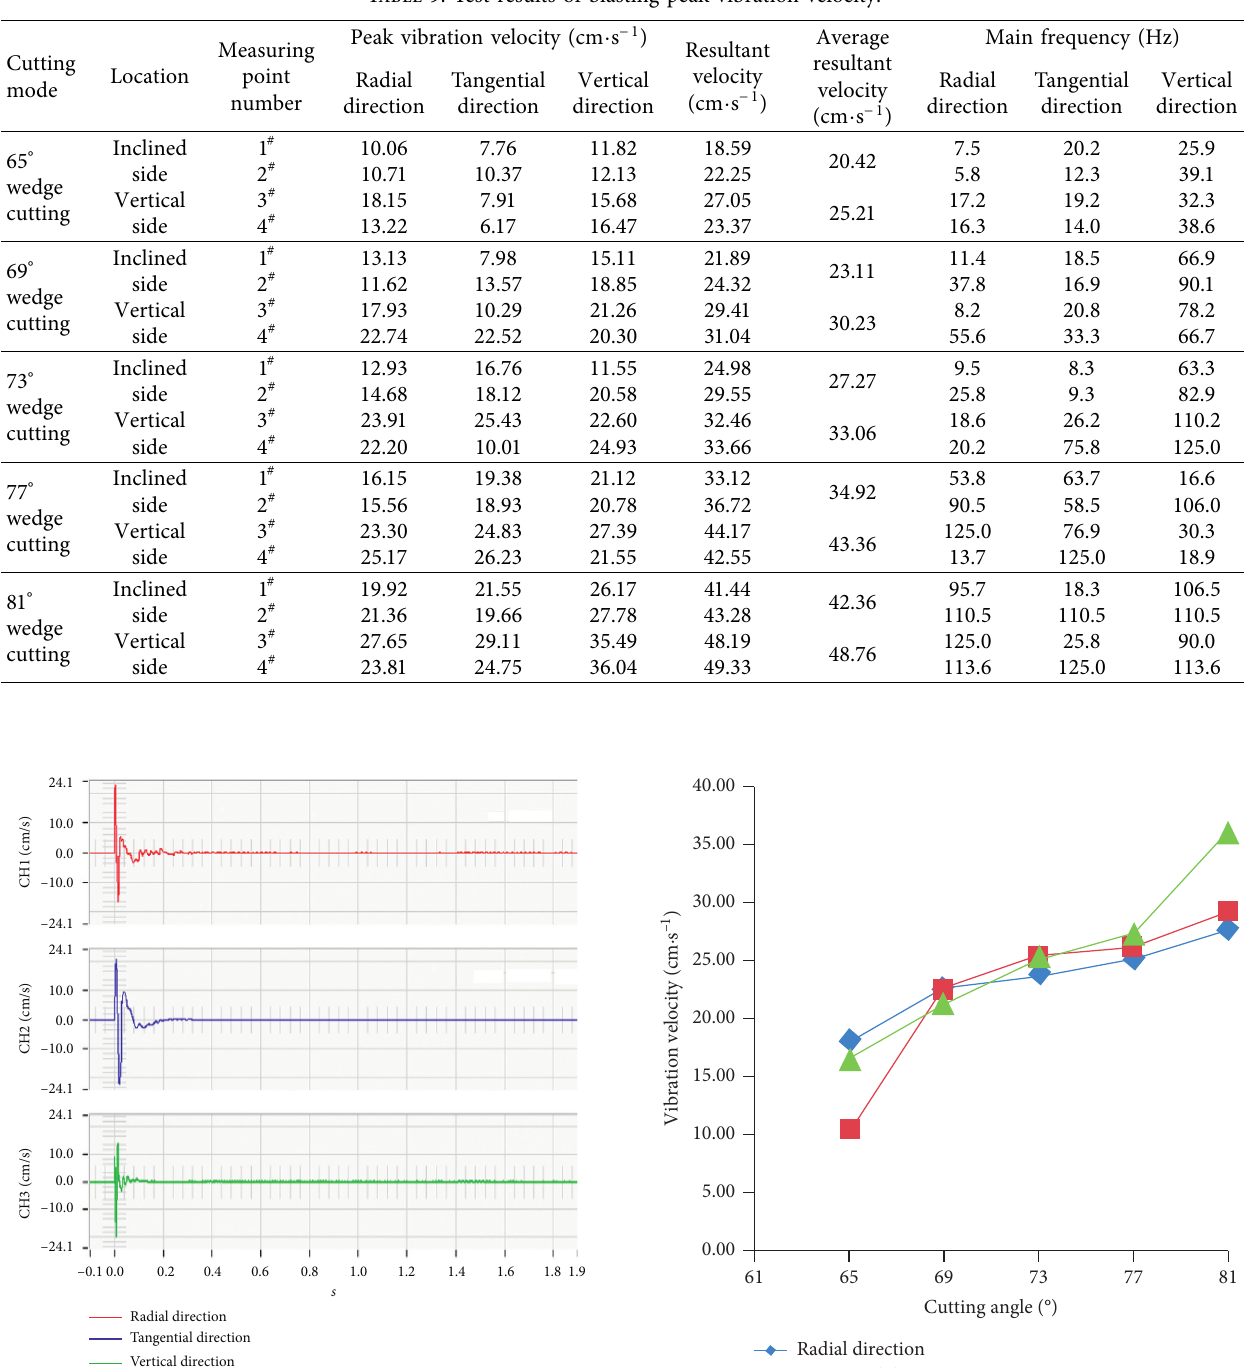
Table 9: Test results of blasting peak vibration velocity.